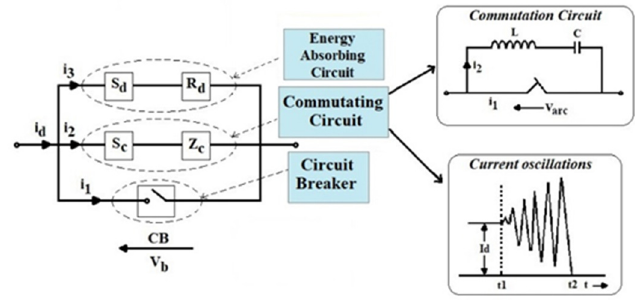
Figure 15. Typical DC circuit breaker arrangement.